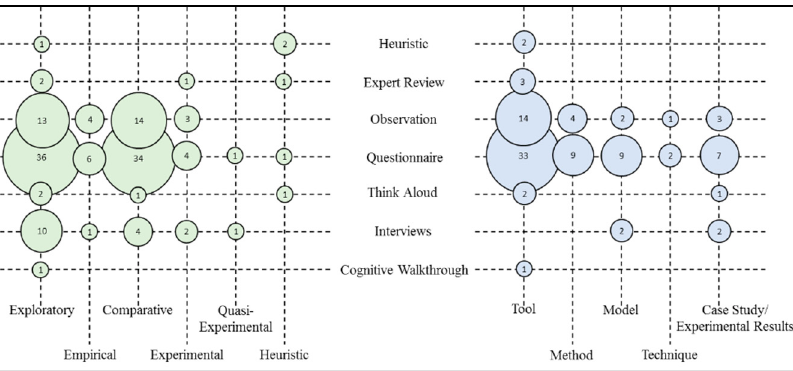
Figure 16. Two-dimensional mapping of research types, common techniques and contribution types.